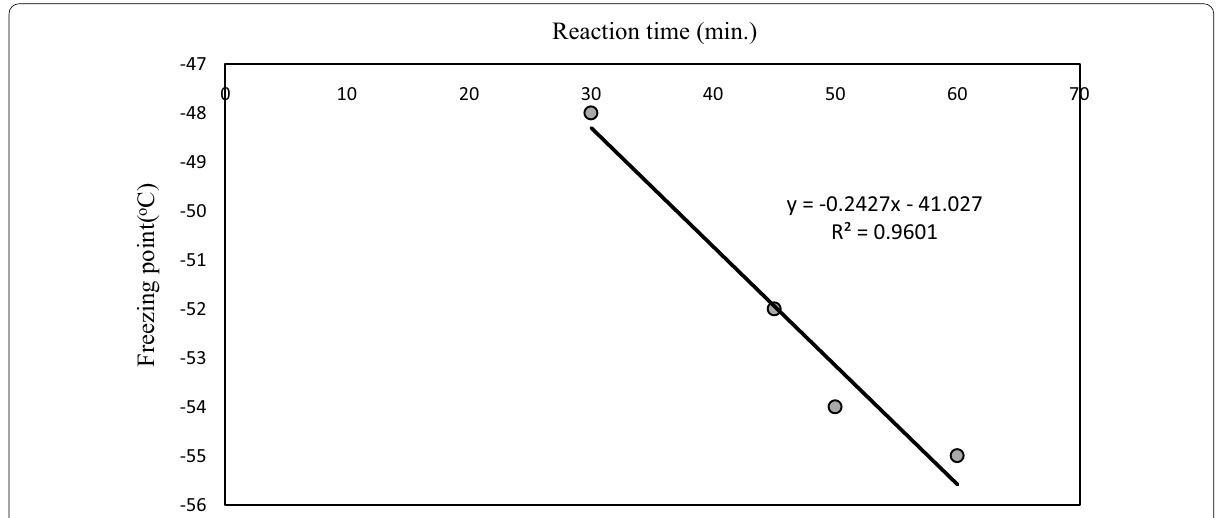
Fig. 5 The effect of reaction time on freezing point of bio fuel product from WCO hydro catalytic cracking